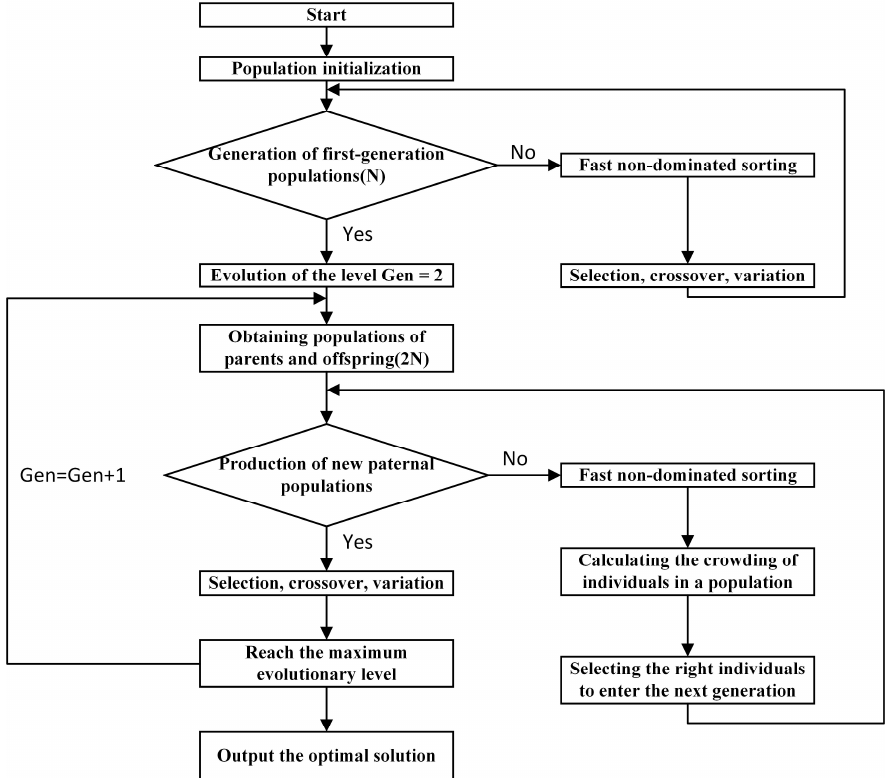
Figure 29. NSGA-II algorithm principle flowchart.